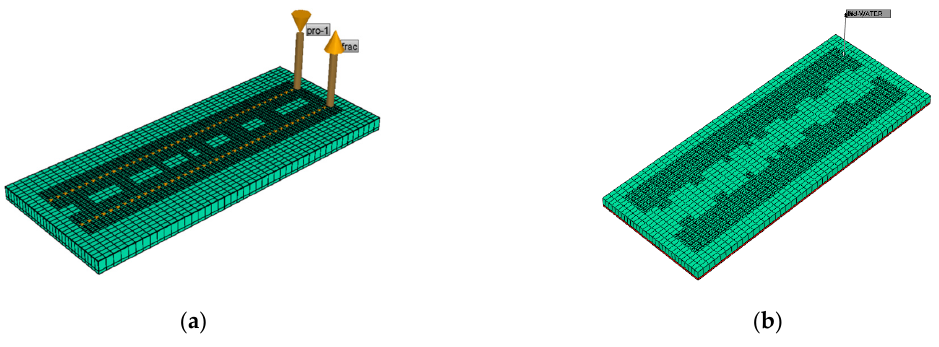
Figure 10. 3 D grid mesh division of numerical models of Scenarios 5 and 6. ( a ) Well spacing is 300 m. ( b ) Well spacing is 510 m.